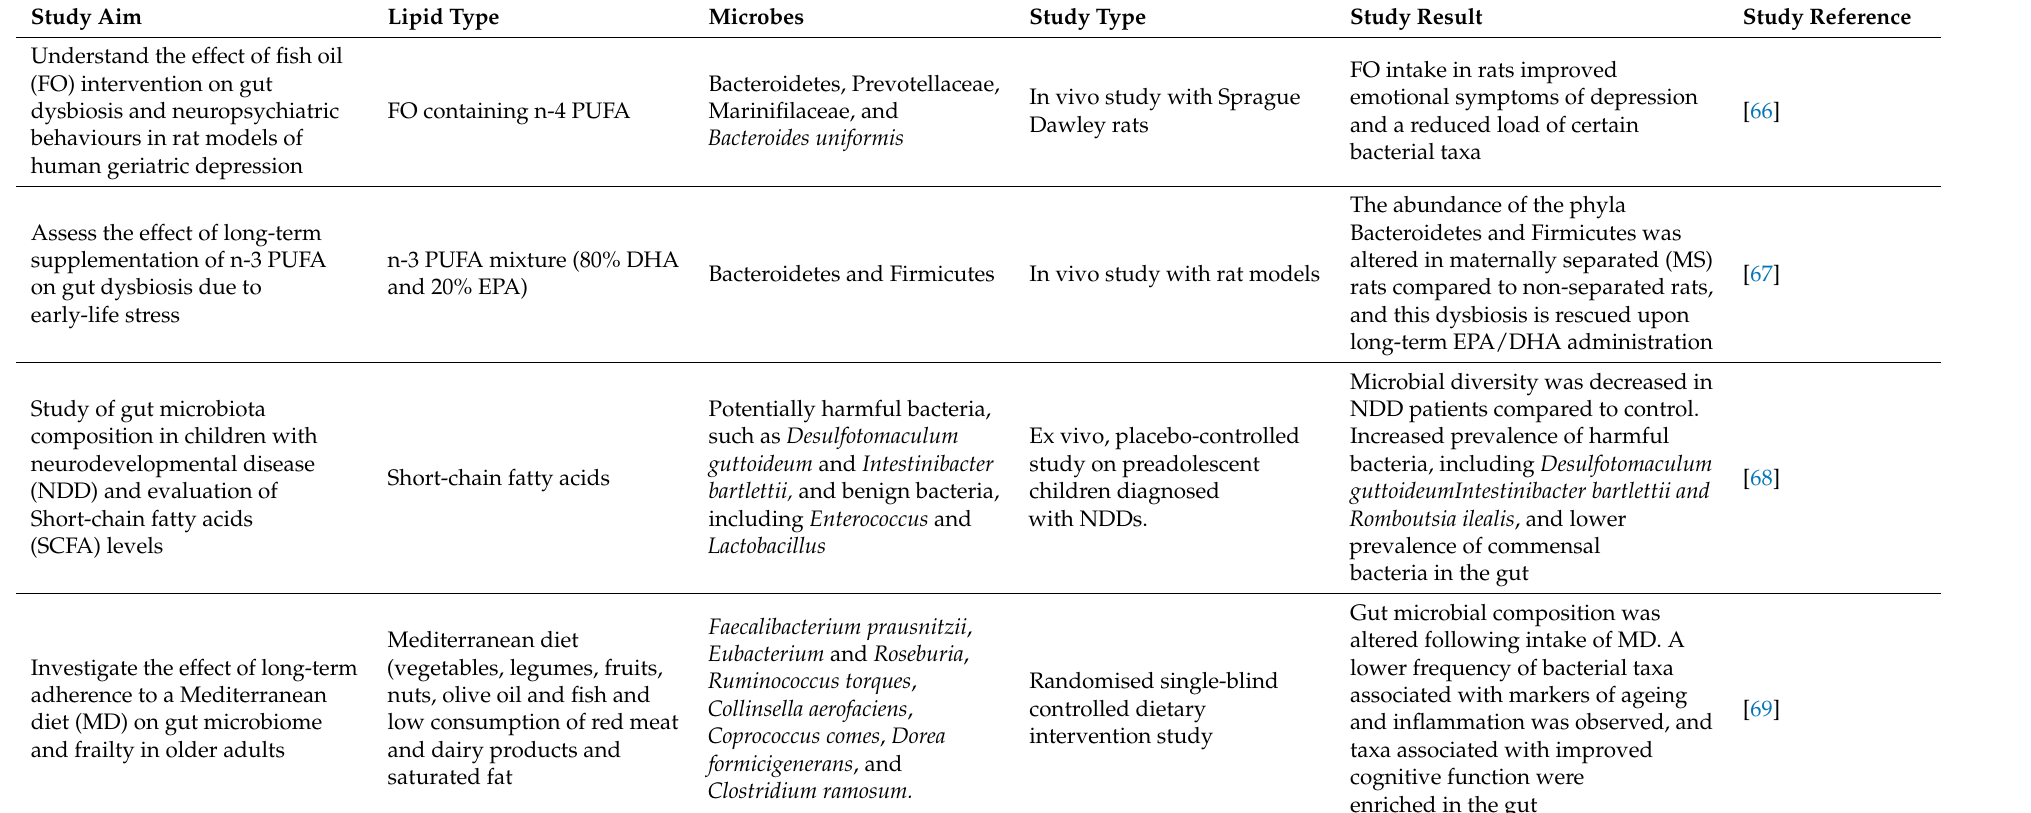
Table 1. Study evidence for lipids and gut-brain signalling: Microbe-dietary lipid